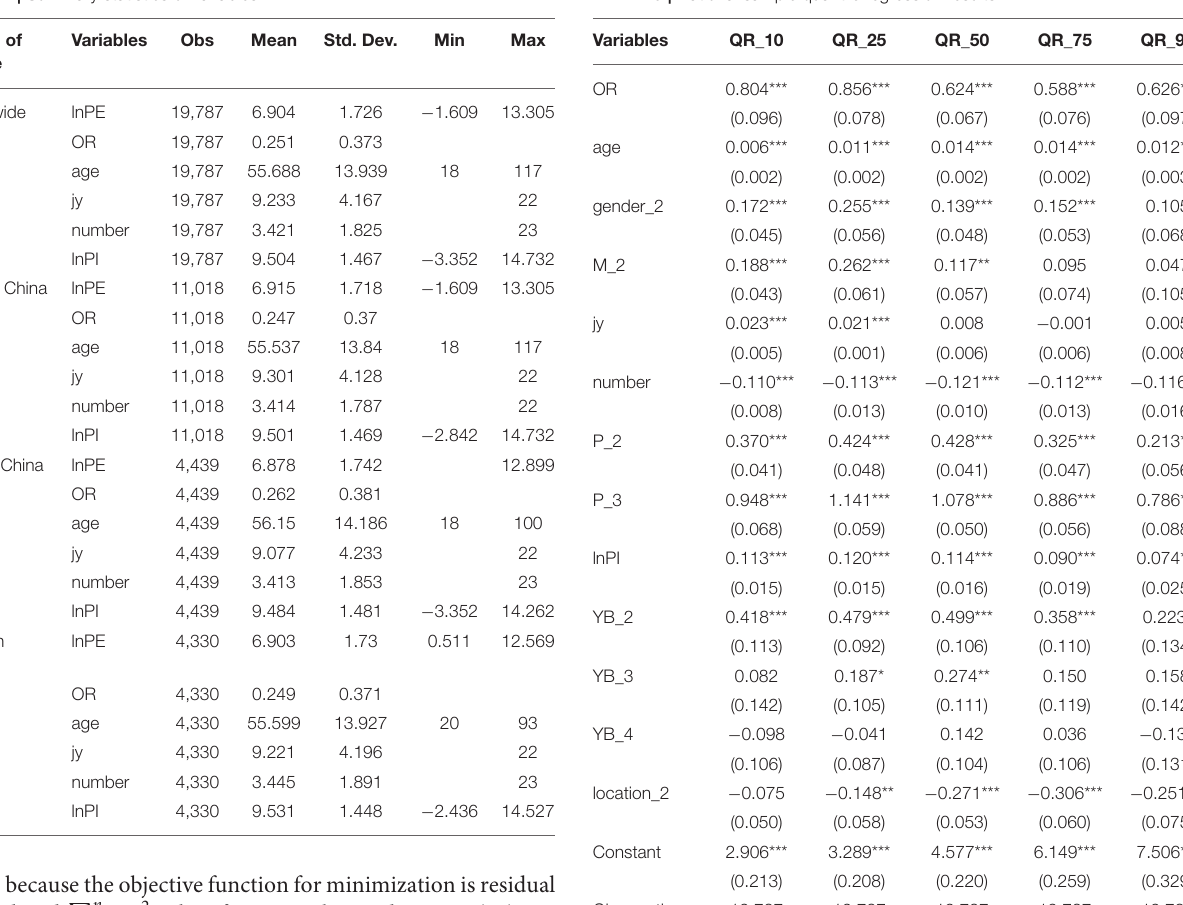
TABLE 3 | National sample quantile regression